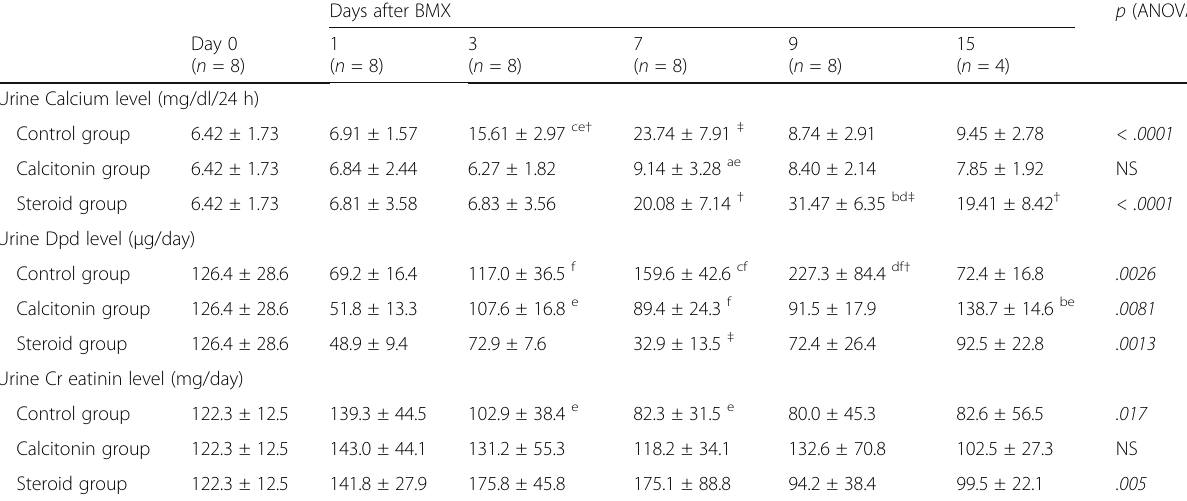
Table 2 Results of urine calcium, Dpd, and creatinin values after BMX Days after BMX